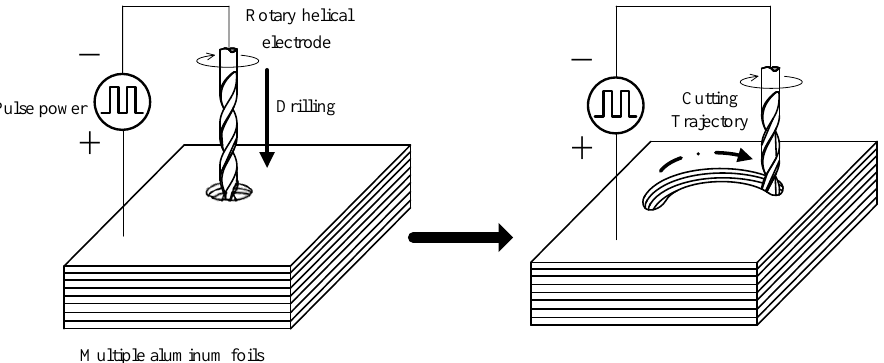
Figure 1. Schematic diagram of electrochemical micromachining of aluminum rings.